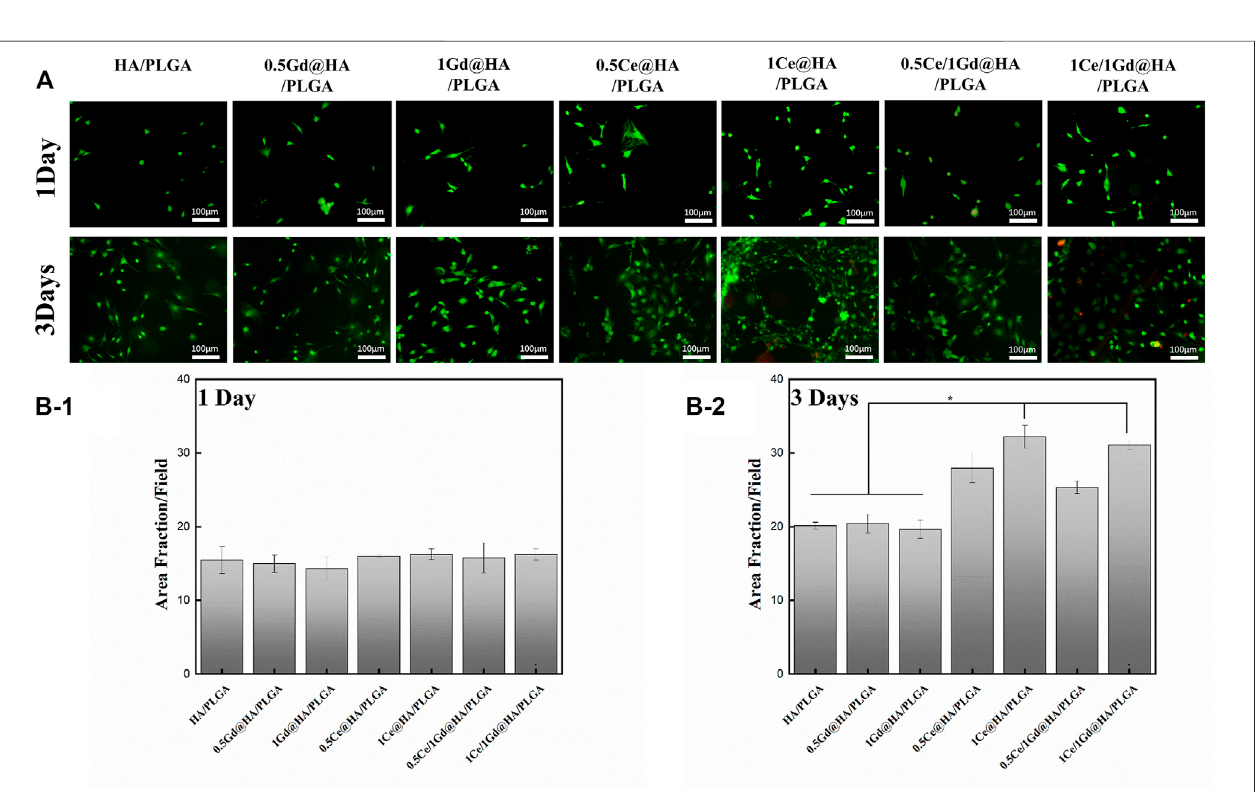
FIGURE6|(A) ComparisonofmorphologyofMC3T3-E1 cellsafter 1and3days,whichwereculturedonHA/PLGA,0.5Ce@HA/PLGA, 1Ce@HA/PLGA,0.5Gd@ HA/PLGA, 1Gd@HA/PLGA, 0.5Ce/1Gd@HA/PLGA, and 1Ce/1Gd@HA/PLGA mediums. (B-1 and B-2) Average fl uorescence intensity of MC3T3-E1 cells cultured on varying mediums on 1 and 3 days.* p <